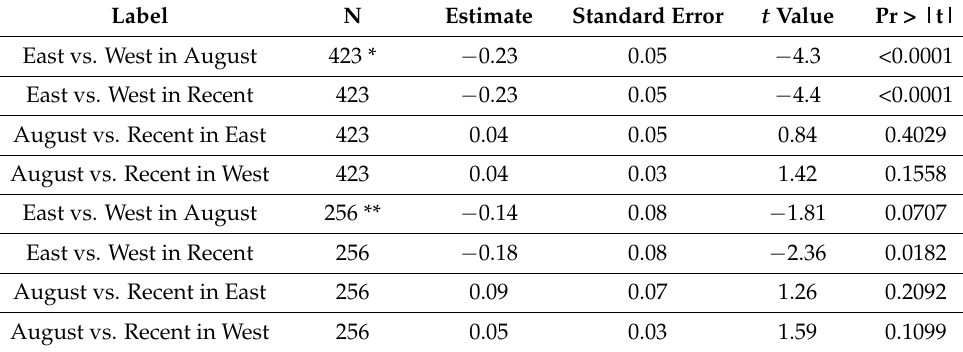
Table 4. Pairwise comparisons between different BLL analysis points (August 2019 vs. MICS-2018; Recent vs. MICS-2018; August 2019 vs. recent) in West and East parts of